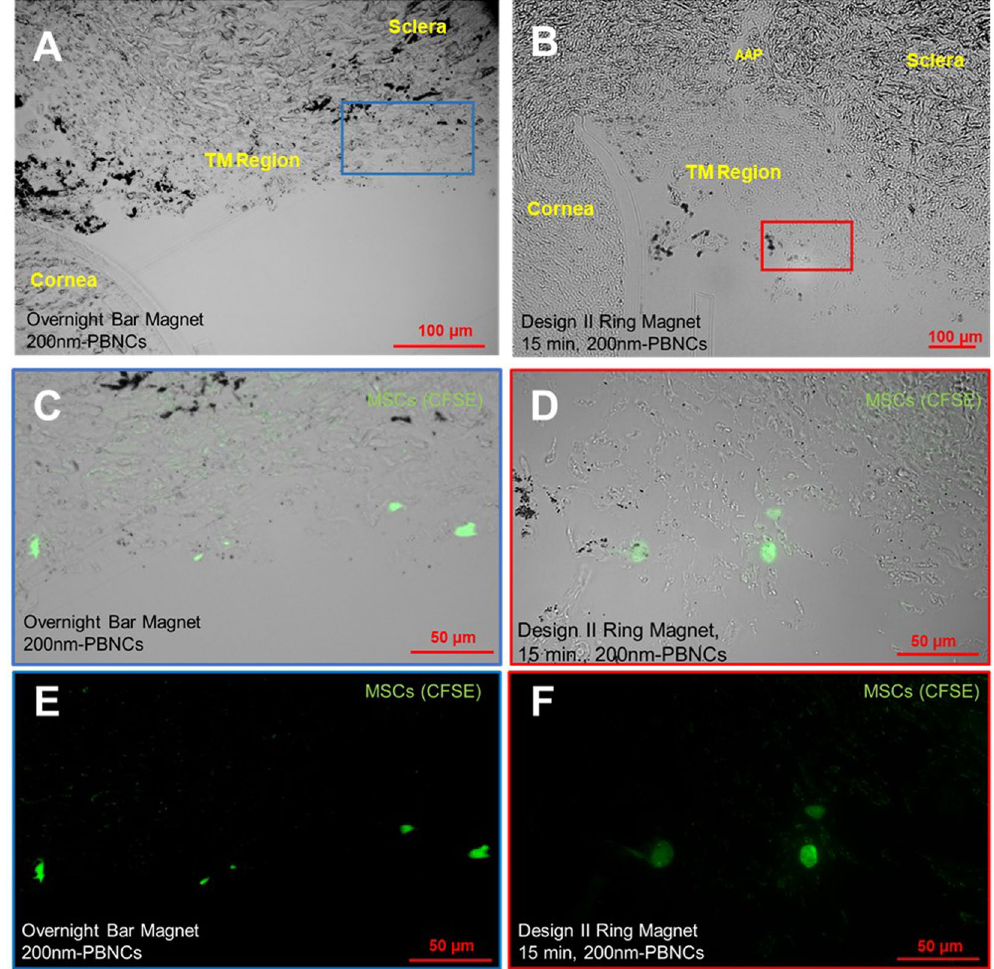
Figure 5. Histological Assessment of PBNC-MSC Delivery to the TM. Representative sagittal sections of the TM region showing fluorescently labeled PBNC-MSCs (green) for (A,C,E) overnight bar magnet exposure and (B,D,F) Design II, 15 minute ring magnet experiments. (A,B) Lower magnification brightfield micrographs are labeled with relevant anatomical features for orientation (AAP = angular aqueous plexus, an analogue of Schlemm’s canal in porcine eyes). The AAP is discontinuous and not present in every section. The TM is identified based on its porous microstructure, relative location with respect to the AAP (when present) and relative location with respect to the limbus (corneal – scleral border). Approximate zoomed regions are shown as blue and red boxes and magnified in panels (C,D) and with the brightfield overlay removed (E,F)